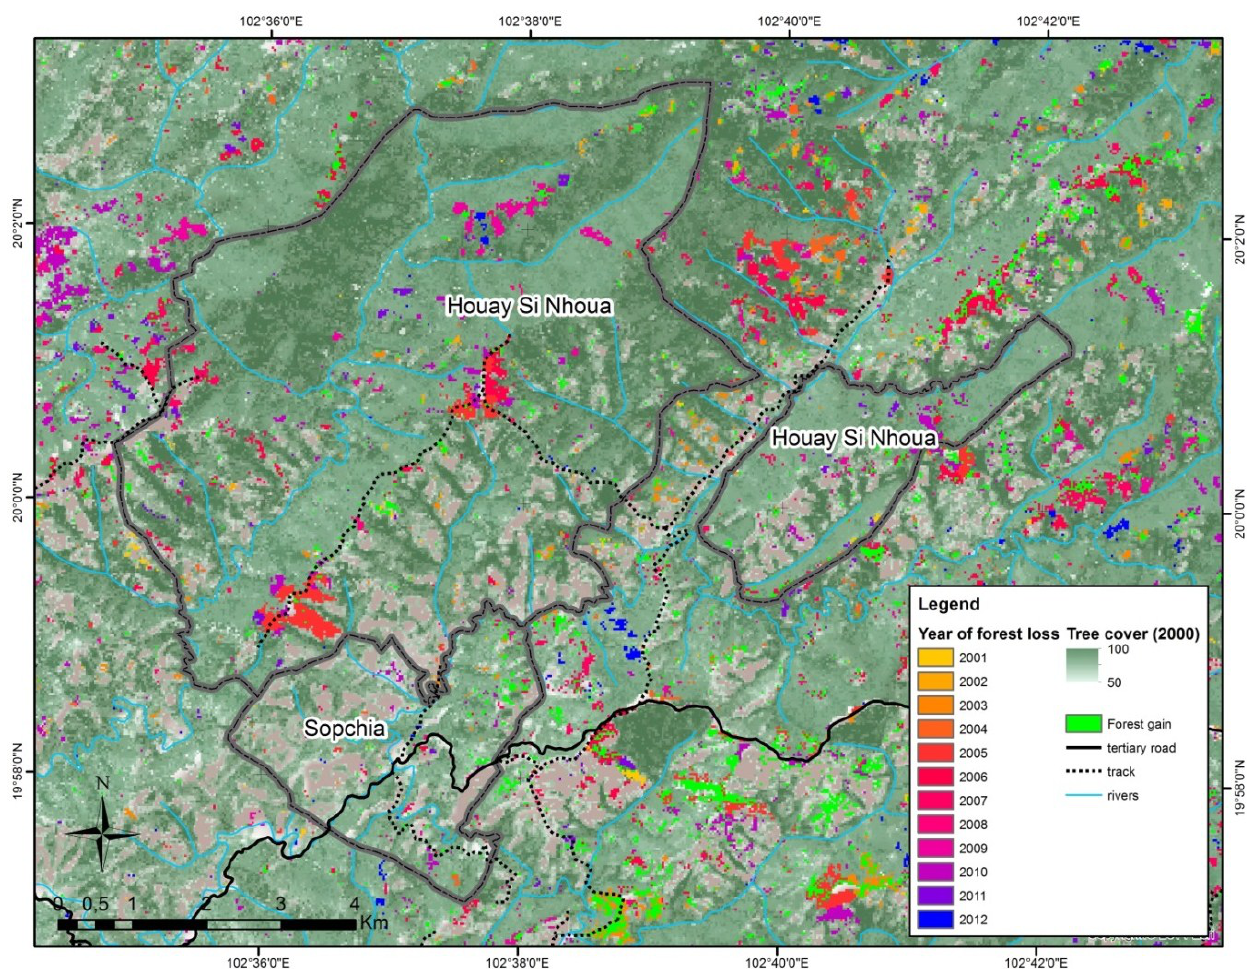
Figure 8. Forest cover change in Sopchia and Houay Si Nhoua by year of forest loss. Forest cover and years of loss after Hansen et al. [13].